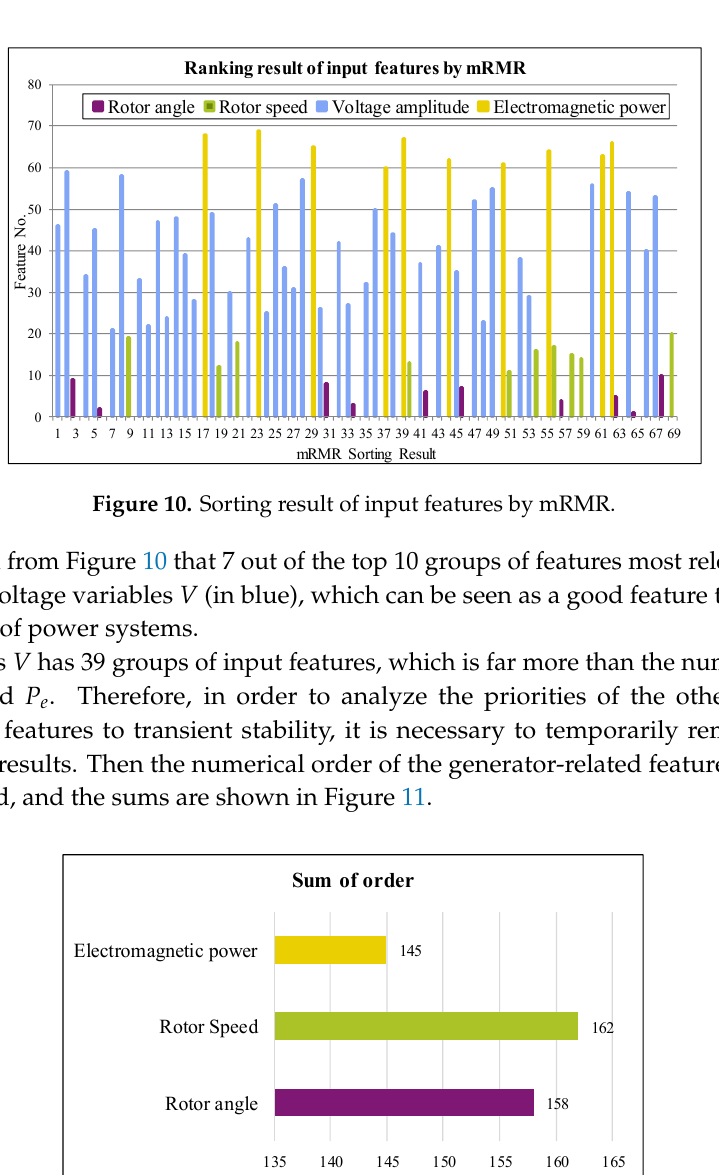
Figure 11. Sum of the order in three types of features.